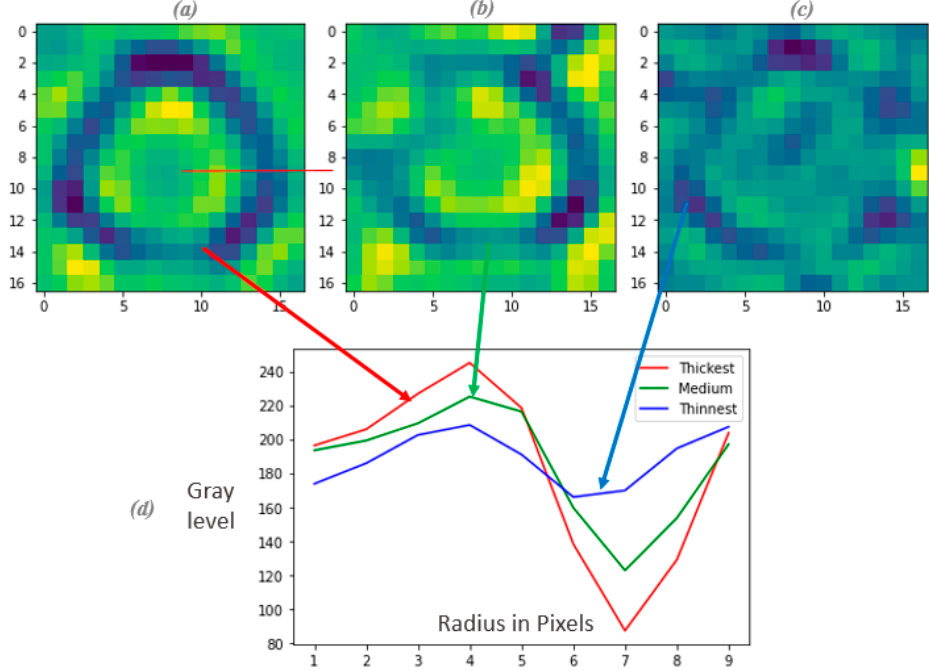
Figure 3. CT images of three fibers with coatings of different thicknesses spanning the range seen in Figure 1b (thickest in ( a ), medium in ( b ) and thinnest in ( c )). ( d ) Radial grey level profiles for each fiber averaged over a set of 48 radial lines obtained by rotating the line indicated in red ( a ) about the center of the fiber in increments of 2 π /48.